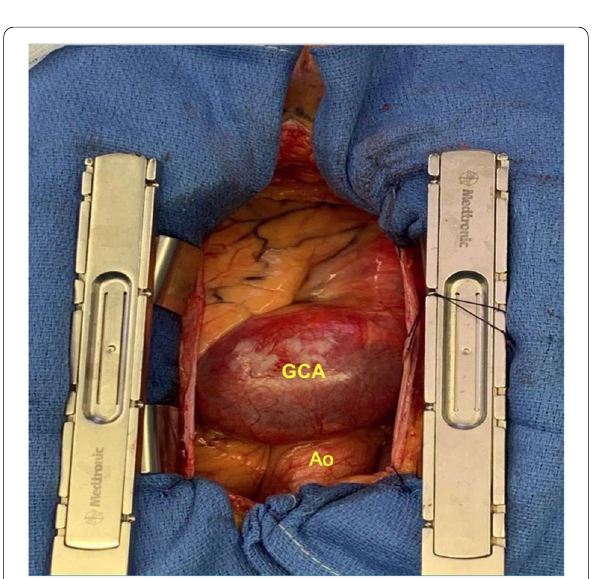
Fig. 3 Immediate visualization of the aneurysm after sternotomy and pericardiotomy. GCA, giant coronary aneurysm; Ao, aorta ascendens